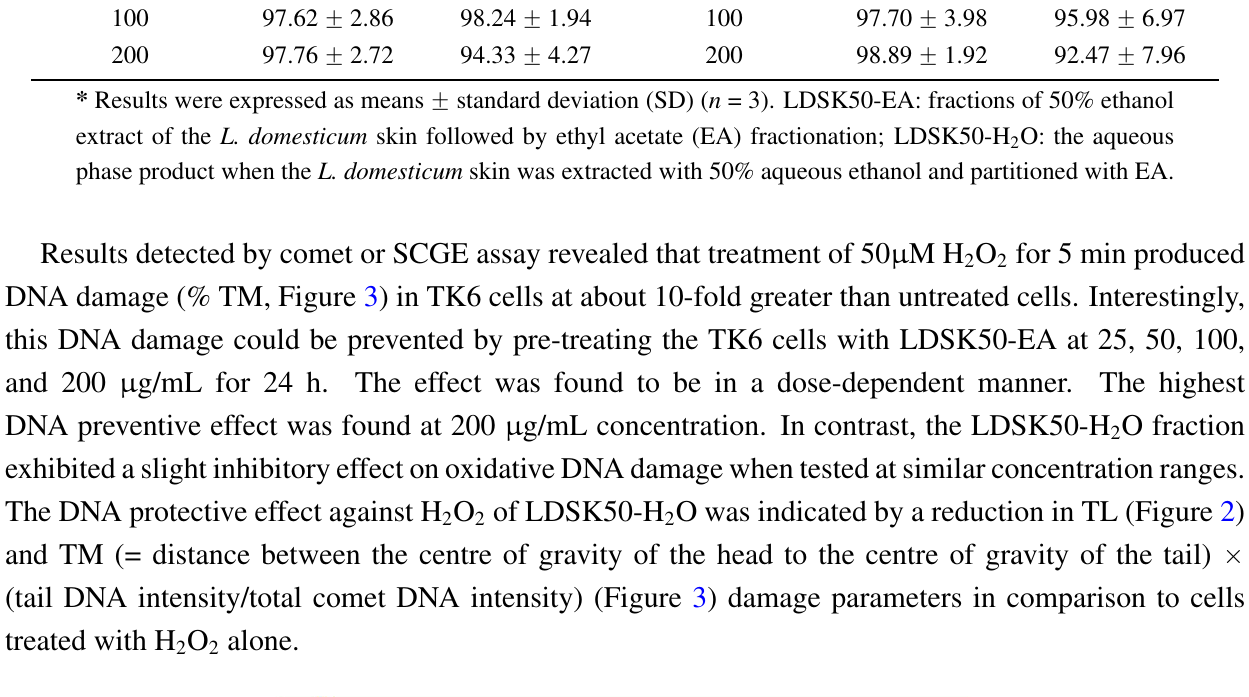
Table 4. Percentage of living cells of pre- and post-H 2 O 2 induction following treatments of TK6 cells with LDSK50-EA and LDSK50-H 2 O measured by the trypan blue exclusion method.